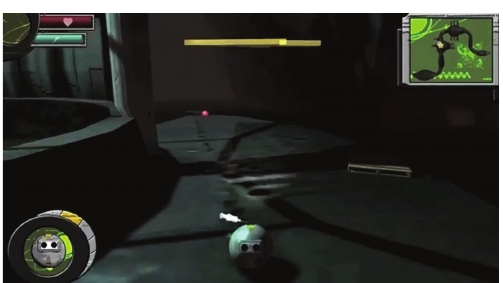
Figure 5: Screenshot of the second level, the cave.